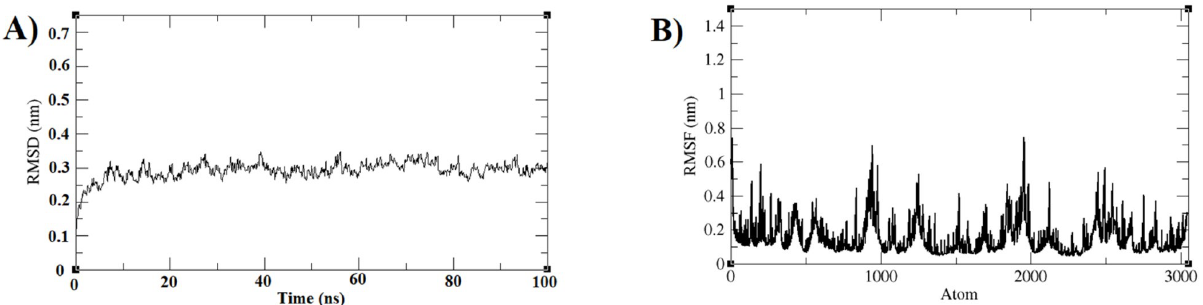
Figure 6. ( A ) Molecular dynamics simulations of AXL-PubChem-122421875 complex active site from the average structure of last 10 nanoseconds of 100 nanoseconds. ( B ) PubChem-122421875 molecule interaction types with AXL kinase active site residues. Protein amino acids are shown in lines, and ligand molecules are shown in the stick model.